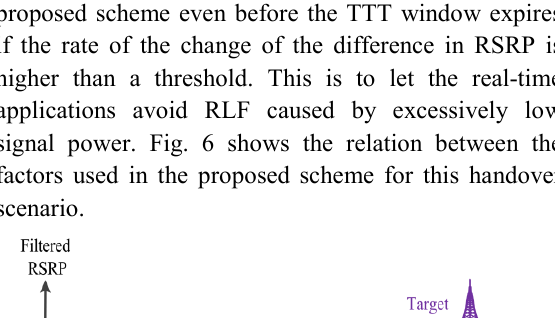
Filtered RD ( t ), FRD ( t ), is obtained by Eq. (13) using the first order auto-regressive ( FOAR ) moving model during each measurement period . Similarly, filtered HD ( t ), FHD ( t ), is obtained by Eq. (14). The use of FOAR allows high channel quality by considering the signal strengths in the previous handover measurement periods. The rate of increase of FHD ( t ), R ( t ) , is determined from Eq. (15). The relative importance of the current and prior measurement period in deciding FRD ( t ) and FHD ( t ) is controlled by the averaging factor, β . Here β is chosen depending on the measurement period ( T m ) and TTT, as β = T m / TTT . A mathematical analysis in [14] shows choosing β in the differential integration by the FOAR model in the proposed scheme provides a stationary stochastic process of FRD ( t ) and FHD ( t